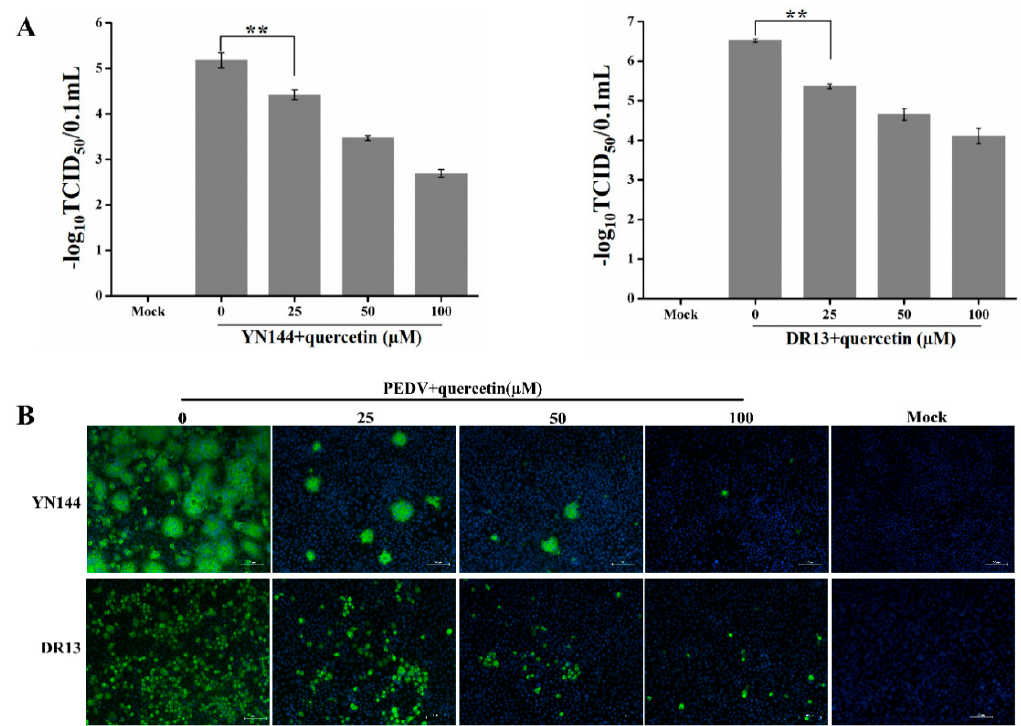
Figure 3. Measurement of the anti-PEDV effect of quercetin by TCID 50 assay and indirect immunofluorescence assay (IFA). ( A , B ) CCL-81 cells were infected with the YN144 or DR13 strain in the presence of quercetin at the concentration of 0, 25, 50, and 100 µ M. Samples were collected and used for the TCID 50 assay and IFA. Data of the TCID 50 are shown as the means ± SD of three independent experiments, with the error bars representing the standard deviations. ** represents a p value < 0.01.